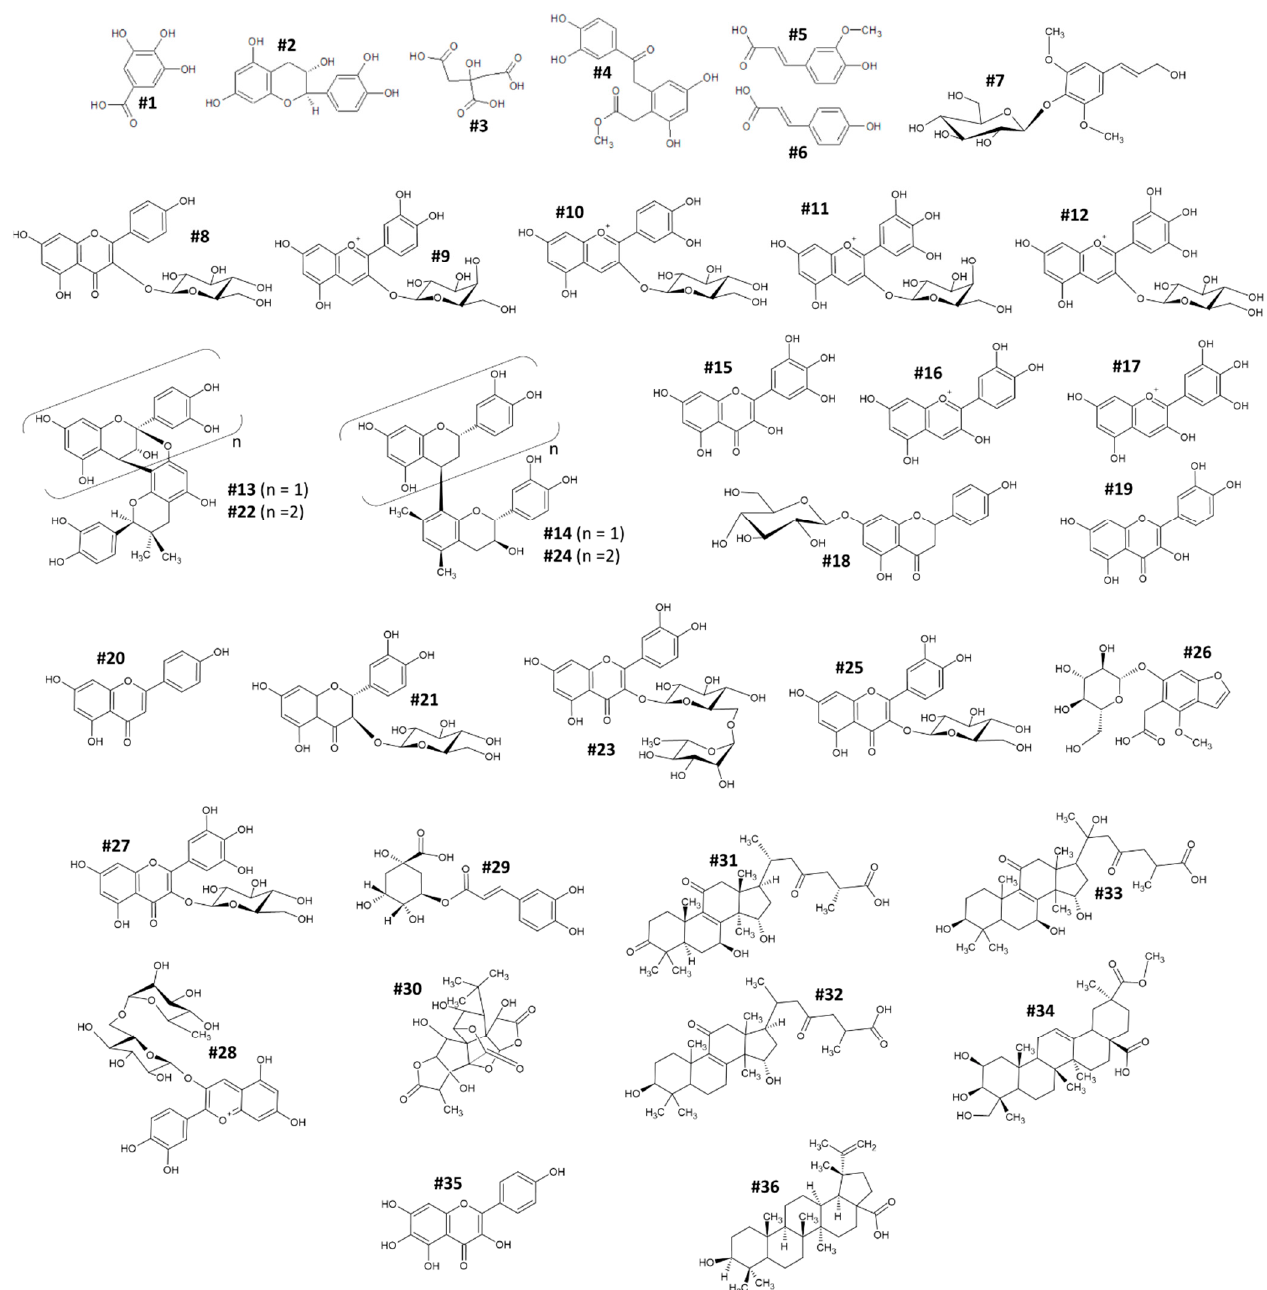
Figure 1. Structural formulas of the bioactive compounds annotated via HPLC-Orbitrap in the extract of Cereja do Rio Grande ( Eugenia involucrata DC).